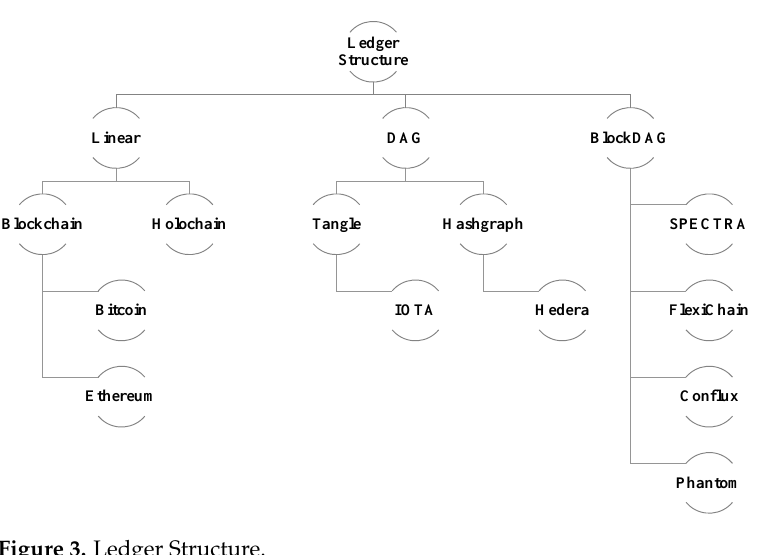
Figure 3. Ledger